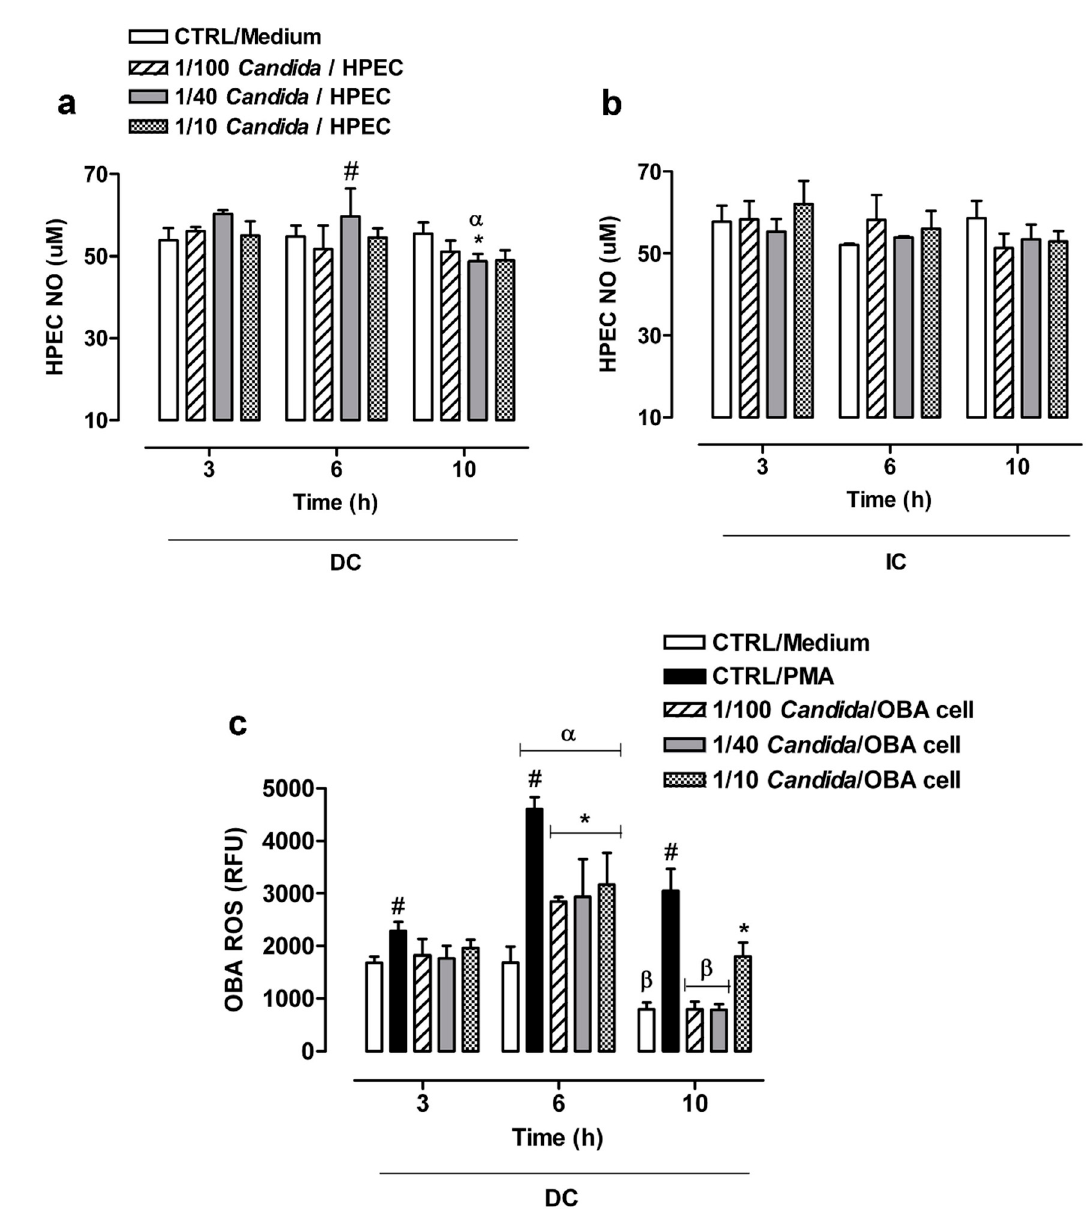
Figure 4. Nitric oxide (NO) and reactive oxygen species (ROS) production by cells